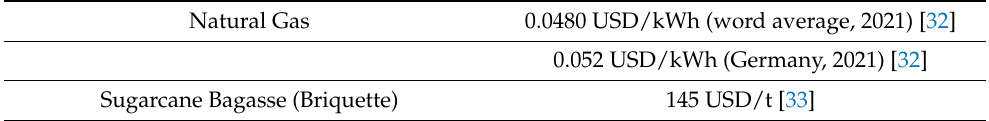
Table 7. Fuel prices reported in 2021.